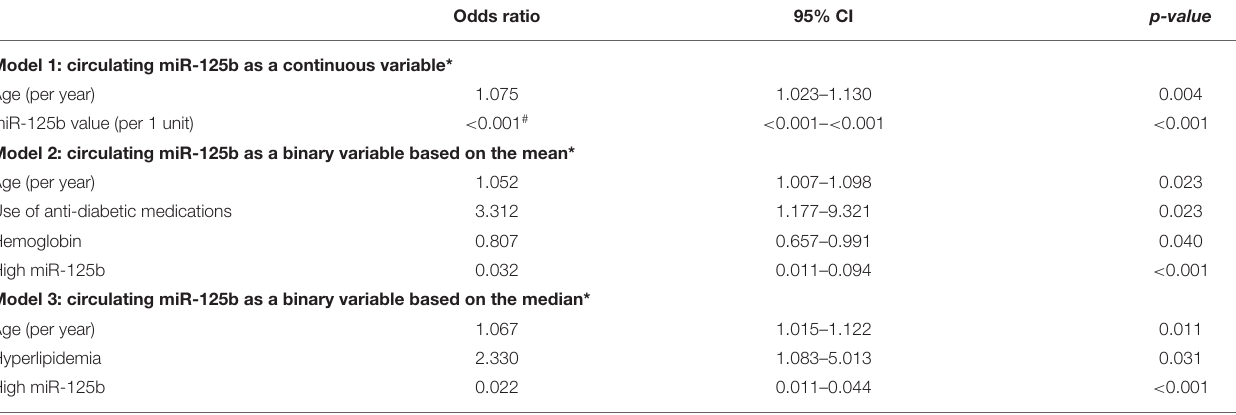
TABLE 2 | Multiple logistic regression analyses with having AAC as the dependent variable. Odds ratio 95% CI p-value